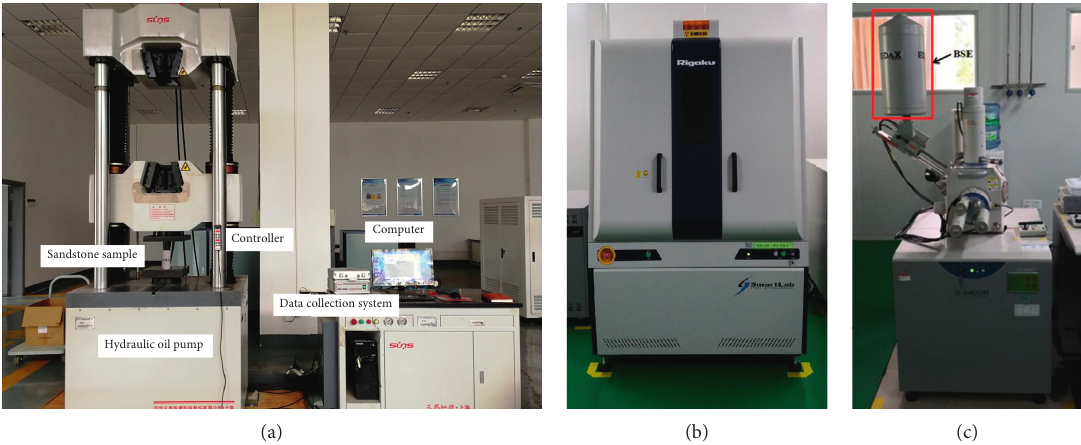
Figure 3: Partial test instrument: (a) WAW-2000 Universal Testing Machine, (b) SmartLab 18KW, and (c) Hitachi